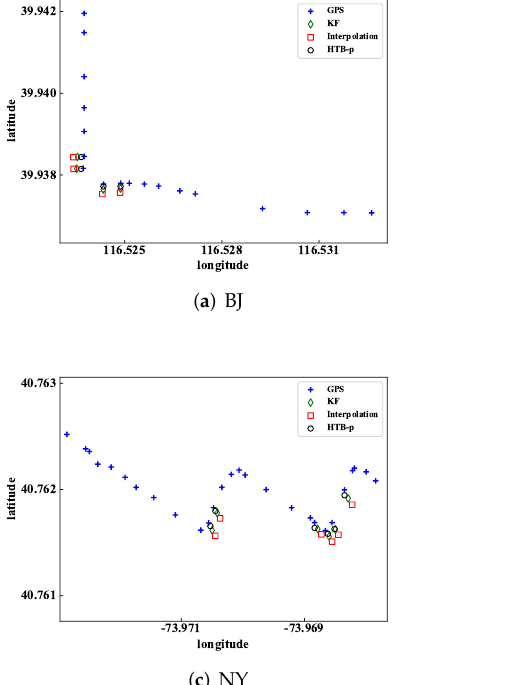
Figure 7. Comparison results of three trajectory restoration methods. ( a ) Comparison of taxi position information restoration in Beijing city. ( b ) Comparison of taxi position information restoration in Shanghai city. ( c ) Comparison of taxi position information restoration in New York city.